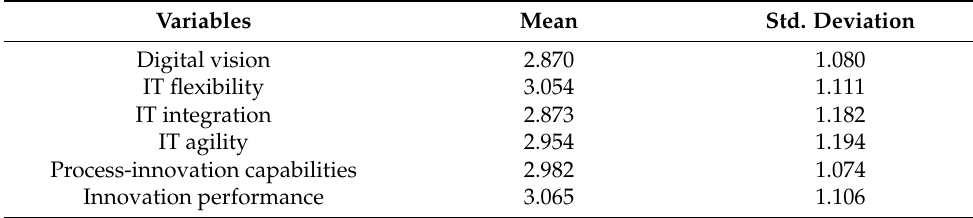
Table 3. Descriptive statistics.